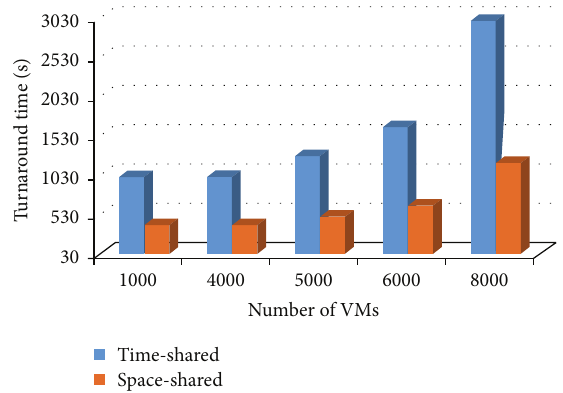
Figure 7: Turnaround time and the amounts of VMs.